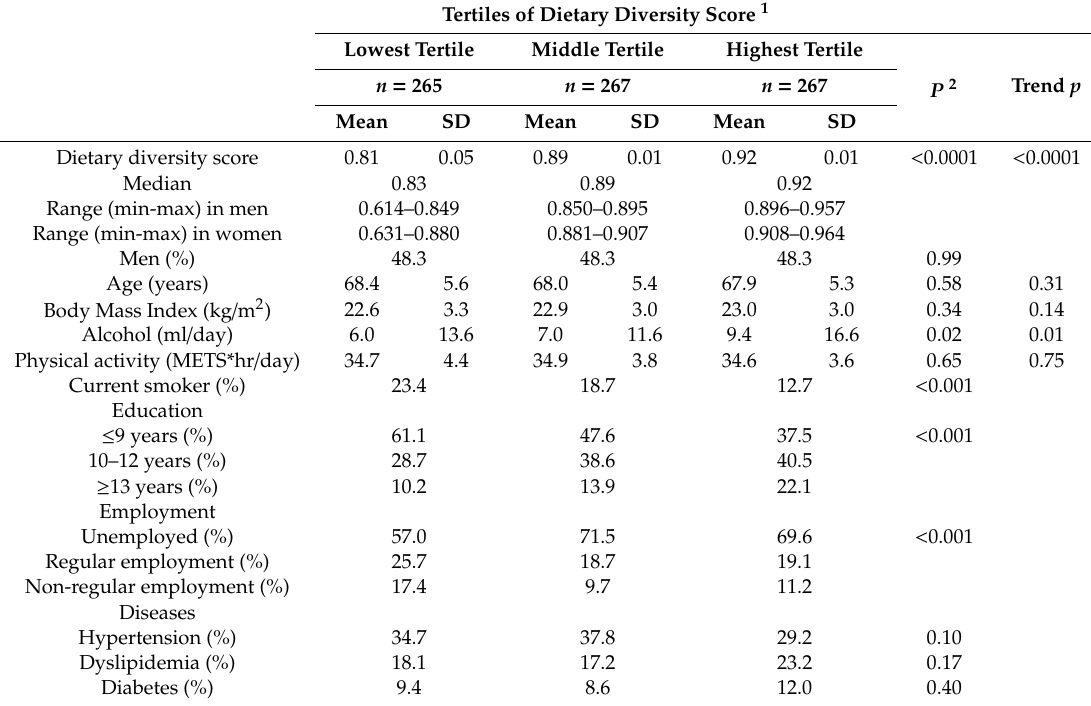
Table 1. Baseline characteristics according to the tertiles of dietary diversity